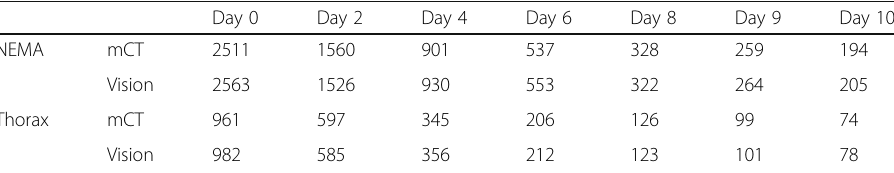
Table 2 Total activity (MBq) in the NEMA and thorax phantoms at time of